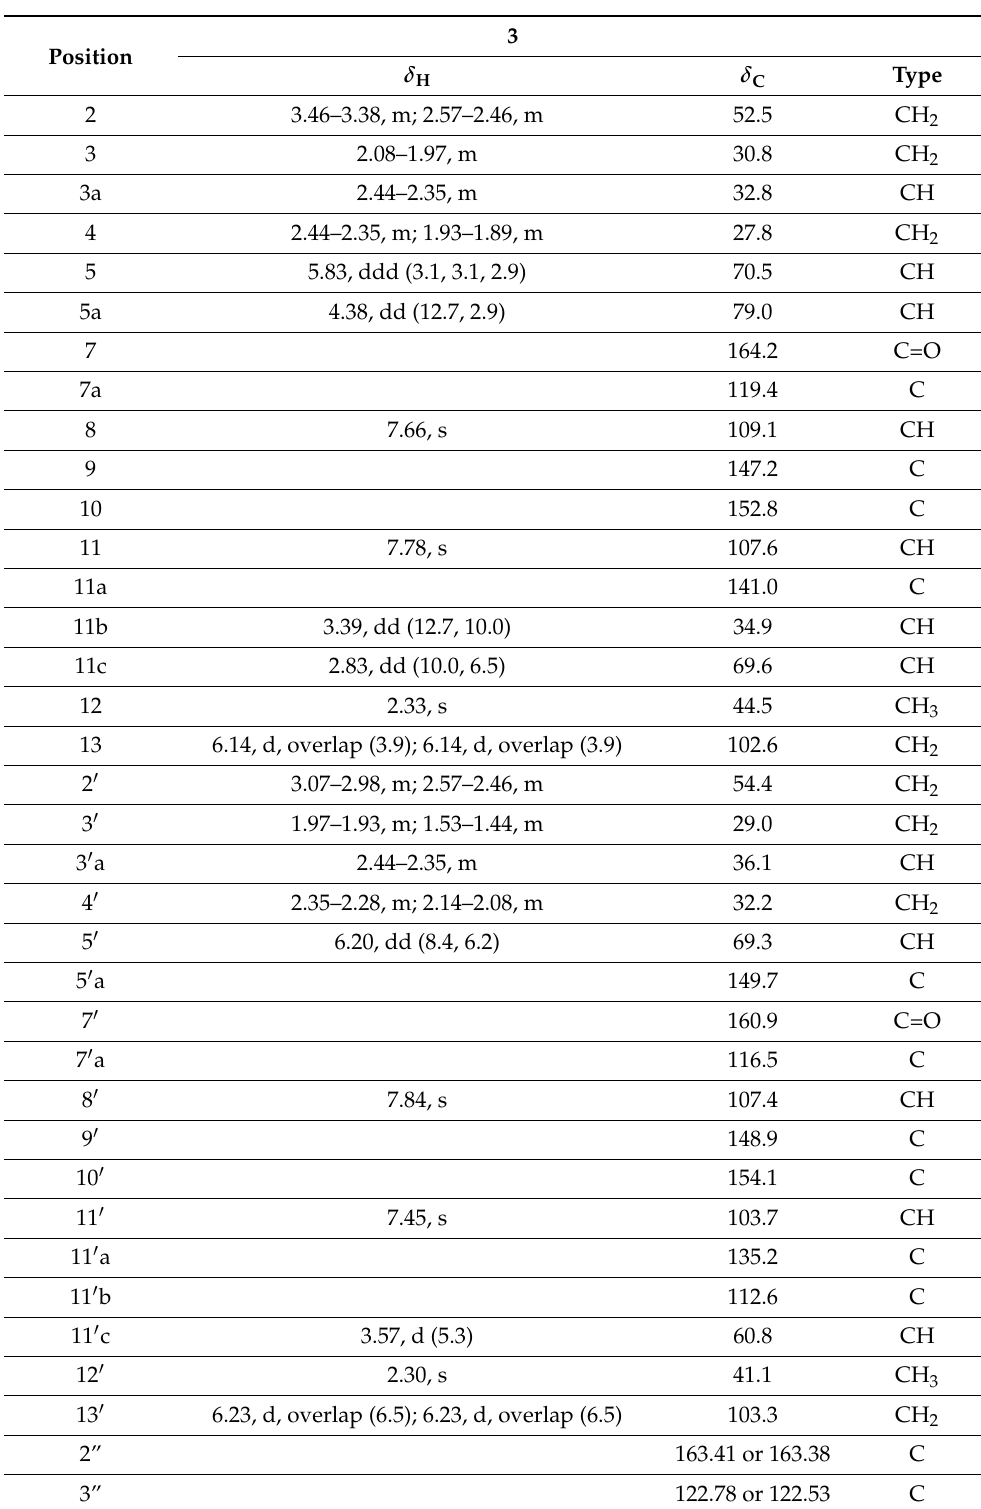
Table 1. 1 H NMR (499.9 MHz) and 13 C NMR (125.7 MHz) data for 3 analyzed in C 5 D 5 N ( δ in ppm and J in